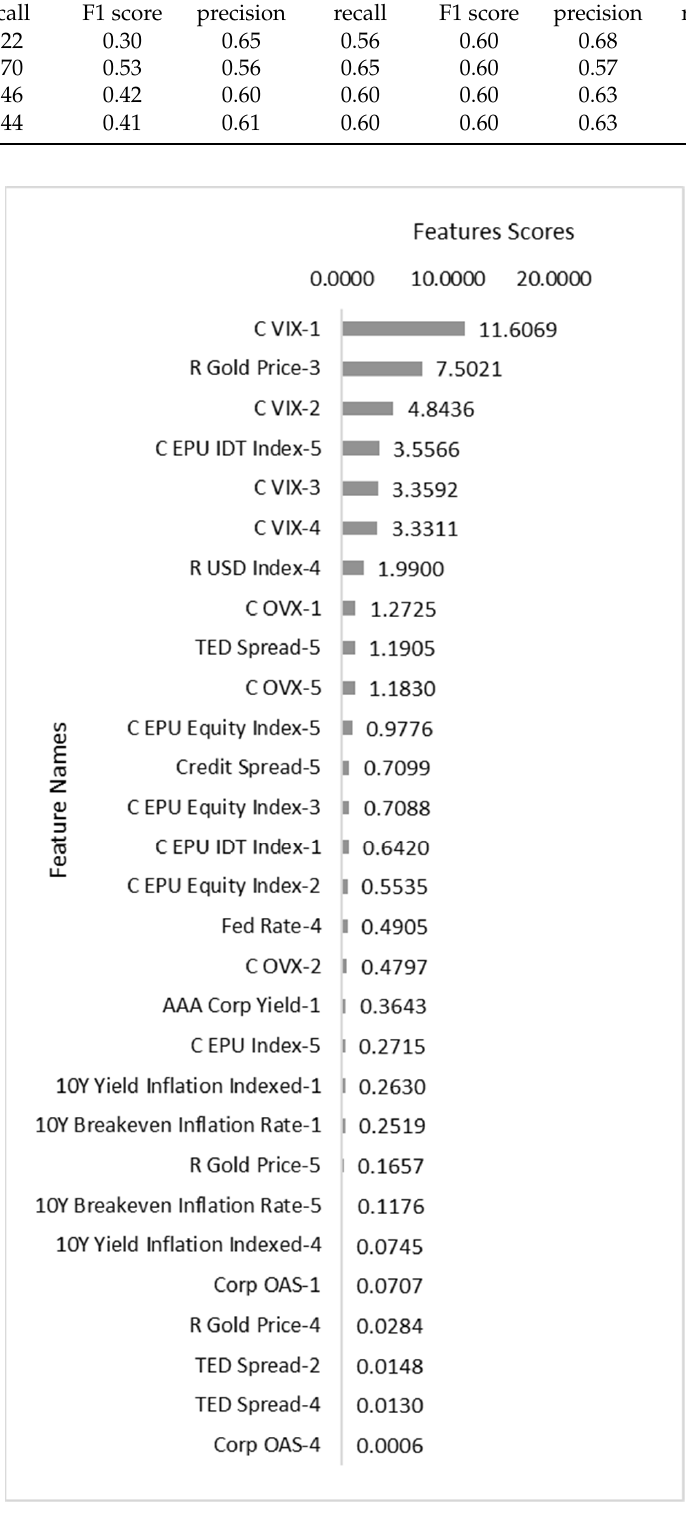
Figure 3. Top twenty-nine daily ranked features from Light GBM. The numbers on the right, truncated to four decimal places, are the features’ scores.